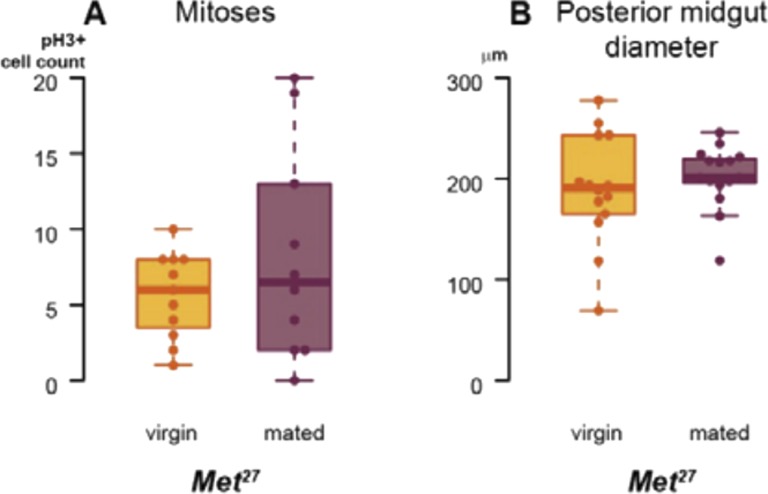
DOI:
http://dx.doi.org/10.7554/eLife.06930.013